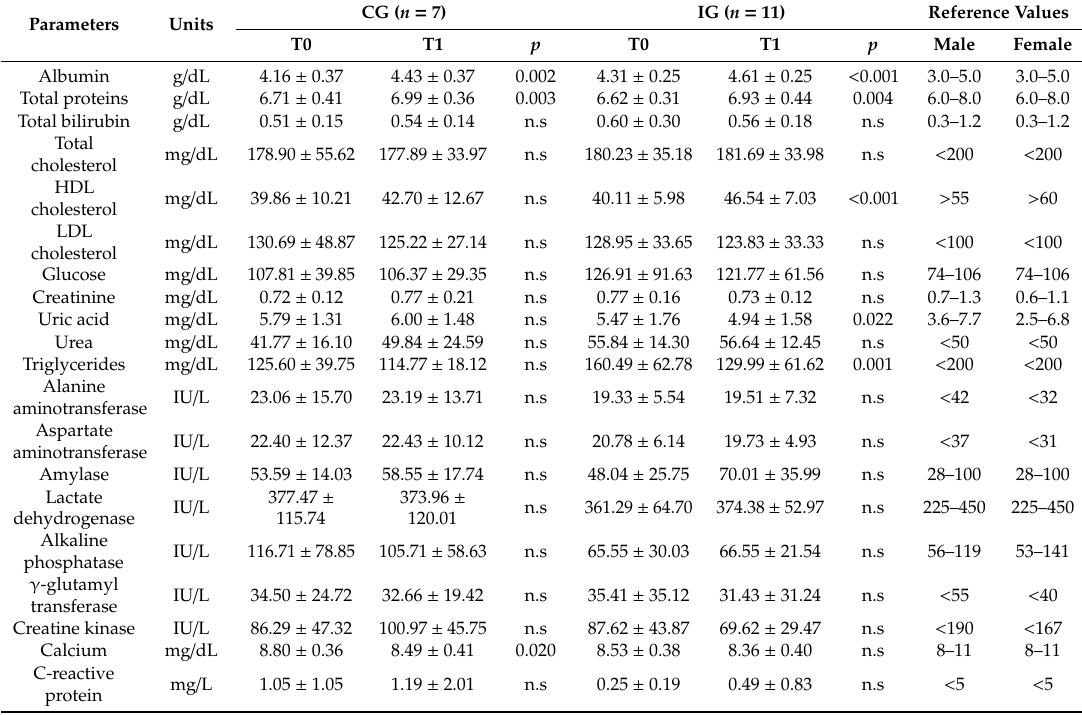
Table 1. Biochemical parameters measured in CG and IG at moments T0 and T1, presented in medium values ± standard deviation and respective reference range